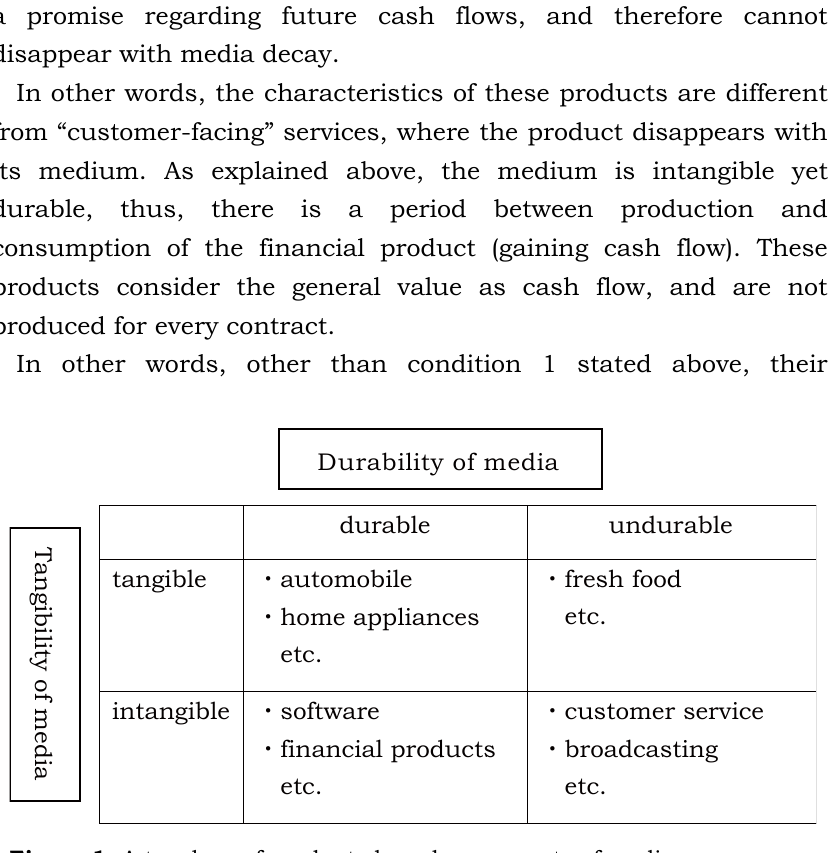
Figure 1. A typology of products based on property of